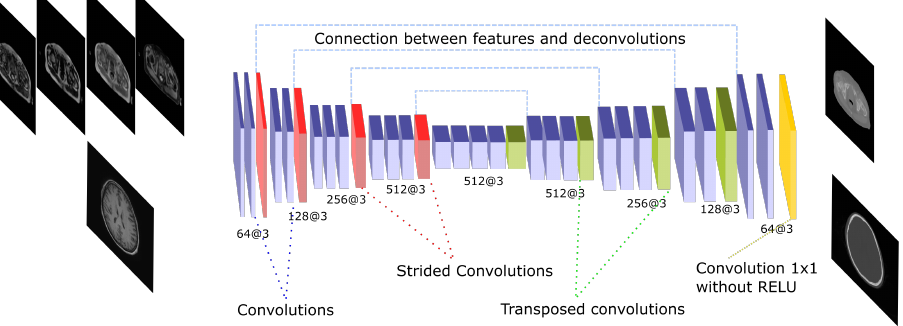
Figure 4. U-Net architecture. The scheme shows the CNN architecture including the encoder and the decoder blocks that are linked by skip connections. The encoding part presents strided operations while the decoding part is composed by transposed convolutions. The network receives either the four Dixon-VIBE MR sequences of the pelvis or the T1-weighted image of the brain as input. Then, it outputs a pelvis or a head pseudo-CT,